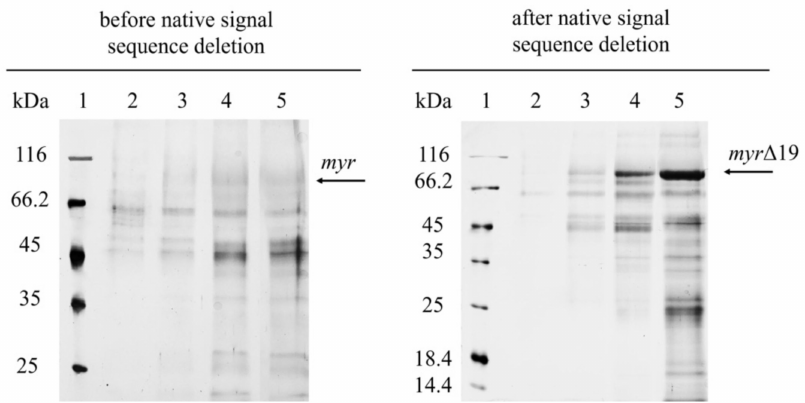
Figure 2. SDS-PAGE analysis of cell-free supernatants from the fermentation of P. pastoris expressing myr and myr- ∆ 19 (after native signal sequence deletion): lane 1—molecular weight marker; lane 2–5—cell-free supernatant taken after 45 h (2); 69 h (3); 140 h (4); 164 h (5) of